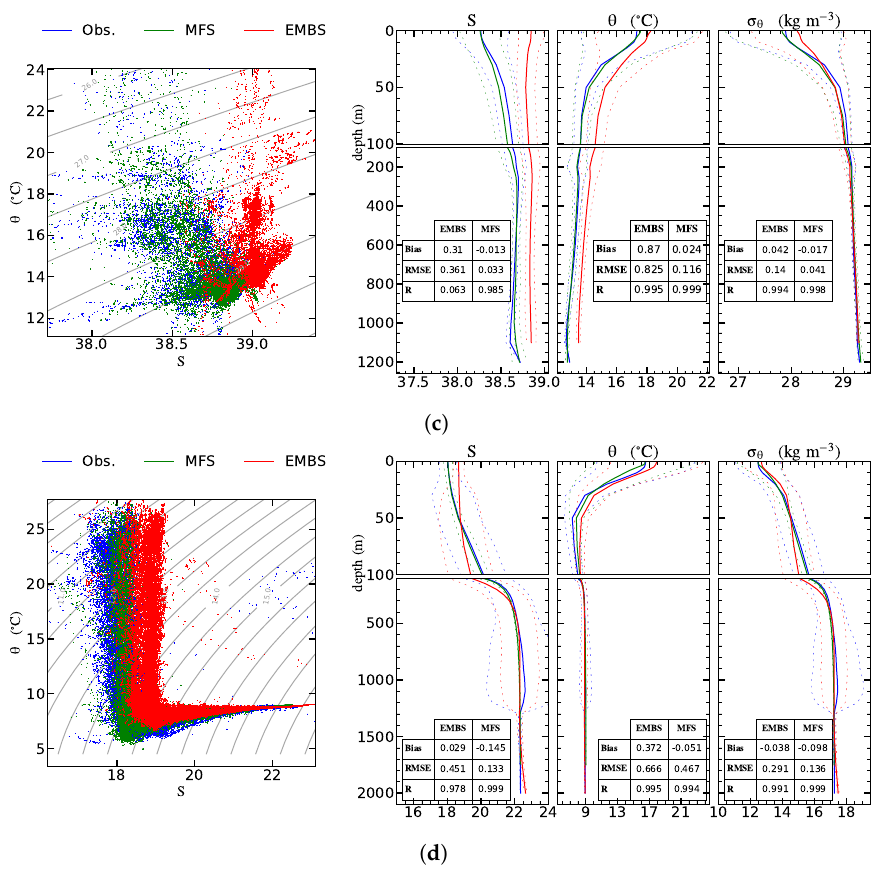
Figure 15. Same as Figure 14, for ( a ) Levantine Sea, ( b ) Ionian Sea, ( c ) Adriatic Sea and ( d ) Black